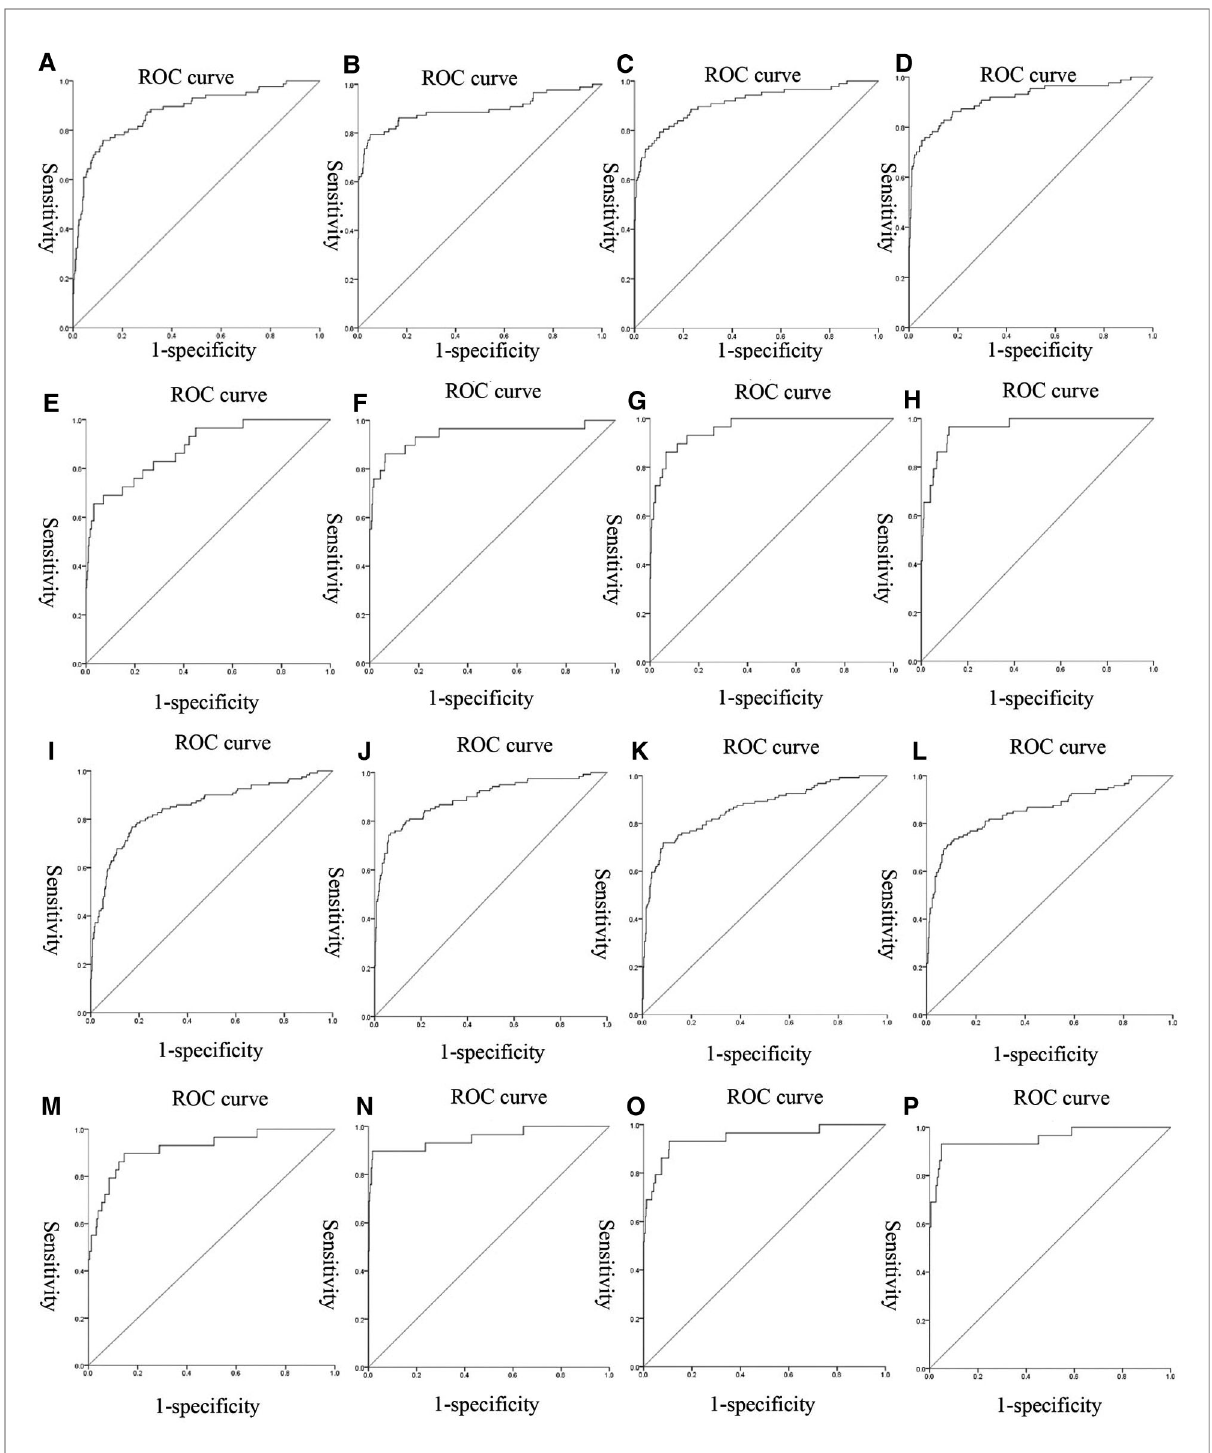
FIGURE 1 ROC curves of the models: ( A – D ) were the ROC curves of the four models of gestational hypertension; ( E – H ) were the ROC curves of the four models of early-onset preeclampsia; ( I – L ) were the ROC curves of the four models of early-onset preeclampsia; ( M – P ) were the ROC curves of the four models of chronic hypertension complicated with